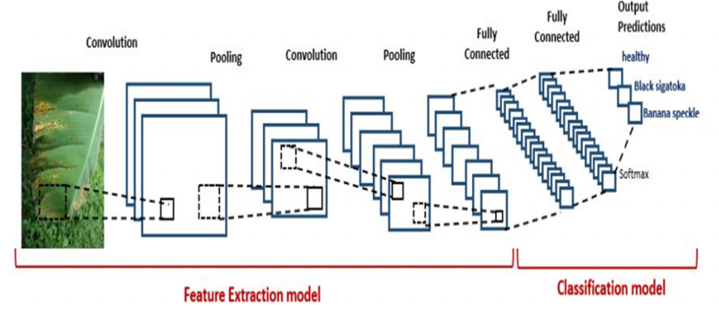
Figure 11. CNN Model from